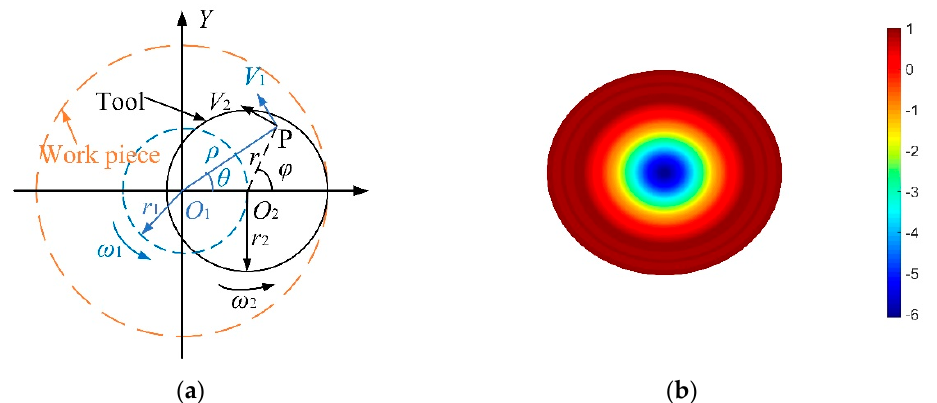
Figure 1. Theory of double-rotor polishing, ( a ) motion analysis of double-rotor polishing, ( b ) simu- lation of TIF.